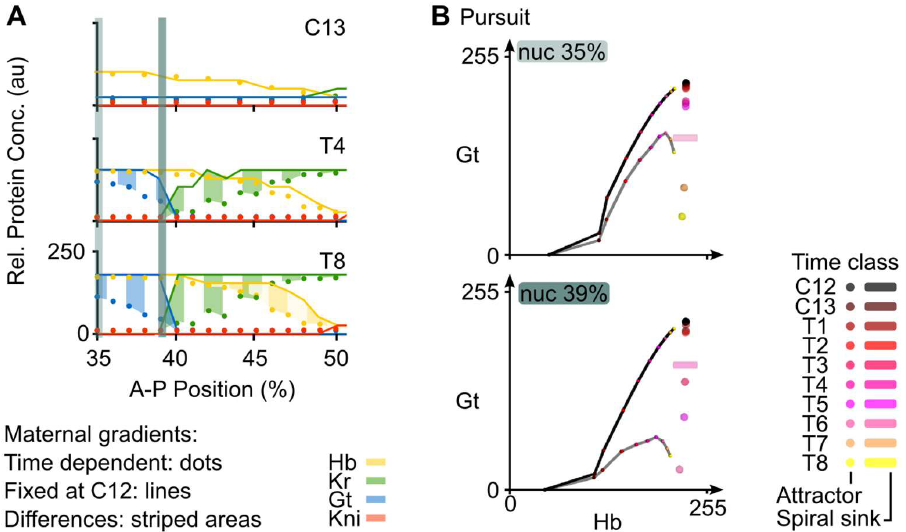
Fig 5. Positioning the posterior boundary of the anterior Gt domain. (A) Output of the non-autonomous gene circuit (dots) versus the same model without maternal gradientdecay (lines) shown at cleavagecycle C13 and C14A (time classes T4 and T8) for nuclei within 35–52%A–P position.Axes and colouring scheme as in Fig 3B. Blue vertical bars mark the nucleiat 35% and 39%A–P positionshown in (B). (B) Phase portraits for nucleiat 35% (top) and 39%A–P position (bottom). Phase portraits are shown as two-dimensional projections onto the plane definedby Hb (x-axis) and Gt (y-axis) concentrations (in arbitrary units, au). Non- autonomous trajectories shown as grey lines and autonomous trajectories as black lines. Attractors shownas spheres(point attractors) and cylinders(indicatinga spiral sink). Small coloureddots on trajectoriesindicate the positionin space of that trajectory at different time points. Colouringof attractors and trajectory positions indicatestime class (see key). Other steady states have been omitted for clarity, since they do not shapethe trajectories in these nuclei.See text for